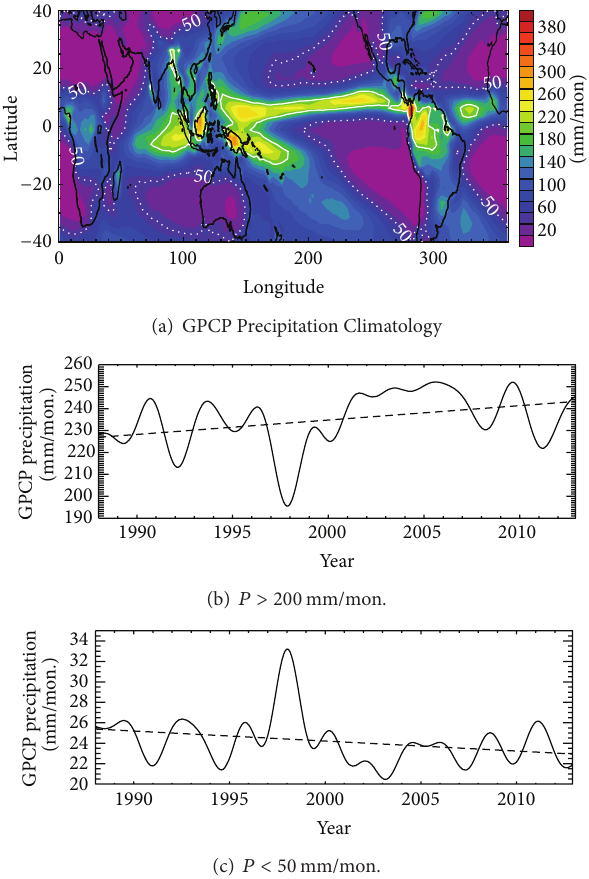
Figure 1: (a) Spatial pattern of the mean GPCP V2.2 precipitation ( 𝑃 ) for 1988–2012 over the tropical and subtropical regions (40 ∘ S– 40 ∘ N). (b) Low-pass filtered time series of precipitation averaged over high-precipitation areas ( 𝑃 > 200 mm/mon.). (c) Low-pass filtered time series of precipitation averaged over low-precipitation areas ( 𝑃 < 50 mm/mon.). El Ni˜no Southern Oscillation (ENSO) signals have been removed from the time series by a regression method based on the Ni˜no3.4 index. A low-pass filter is also applied to remove the high frequency signals. Solid white contours refer to the wet area where the precipitation is higher than 200 mm/mon. Dotted white contours refer to the dry area where the precipitation is lower than 50